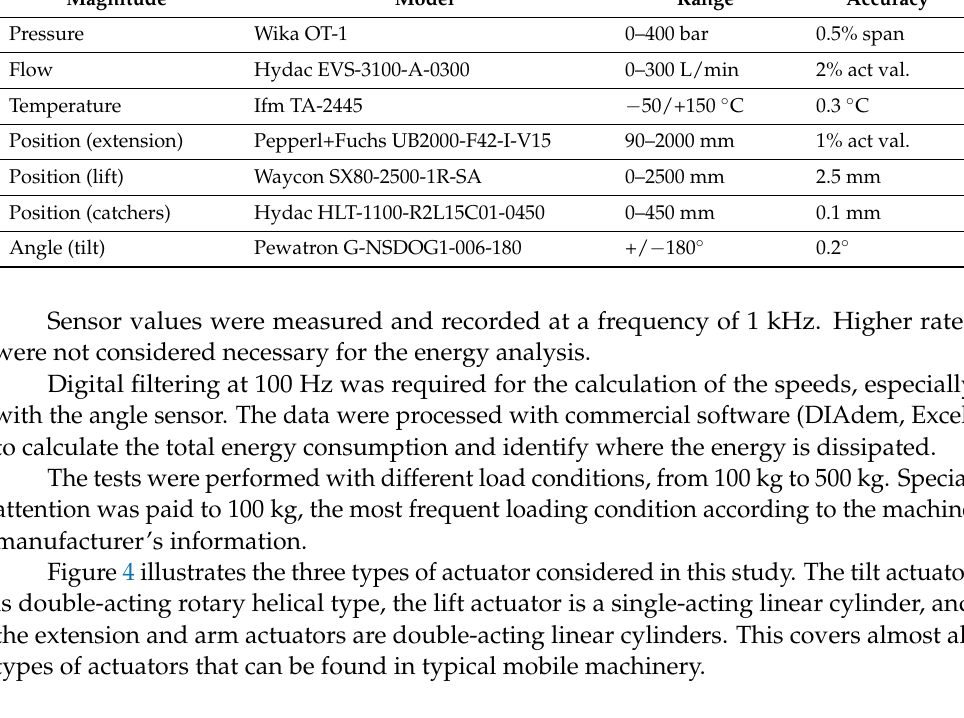
Table 2. Sensors and its characteristics.